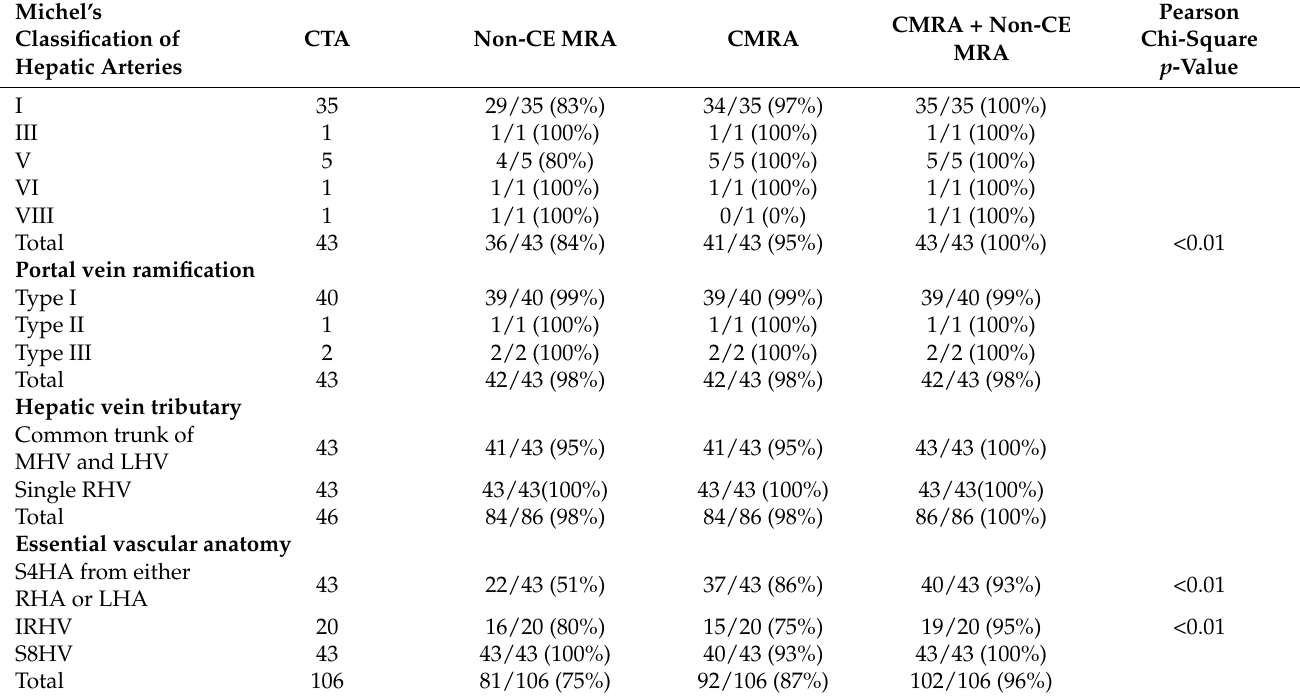
Table 2. Diagnostic performance of non-CE MRA and